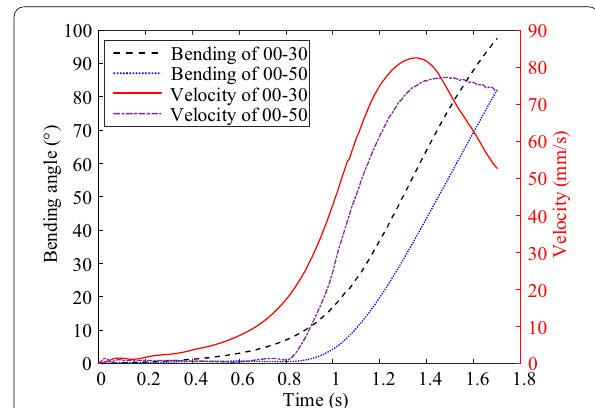
Figure 5 Time change of the bending angle and the end-center point motion velocity